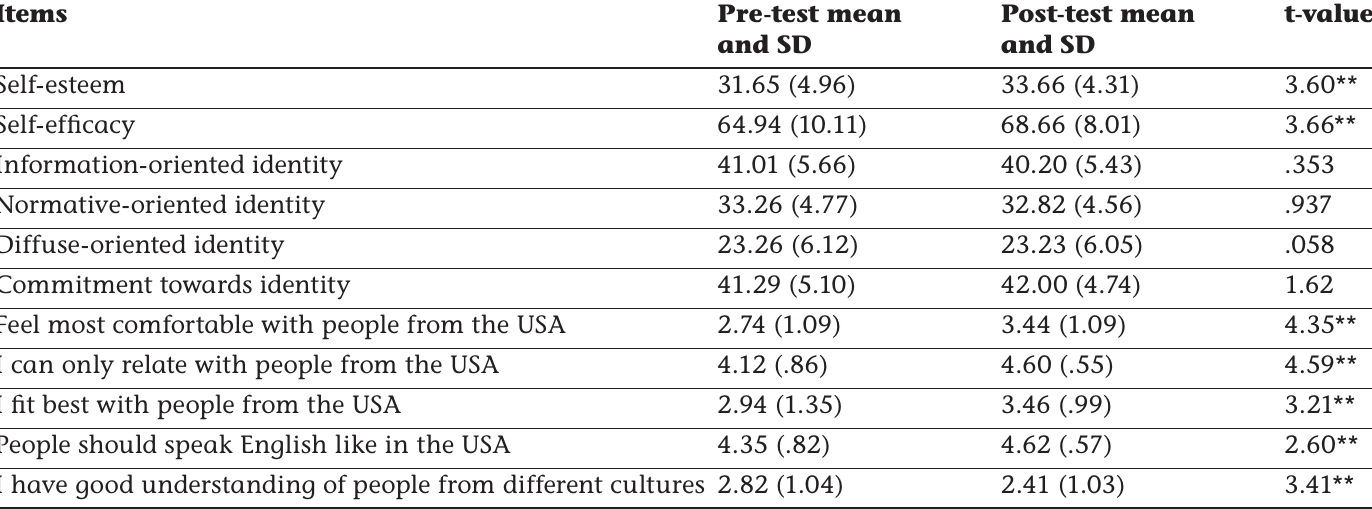
Table 1: Paired sample t-tests: prior to service with OSSO and upon